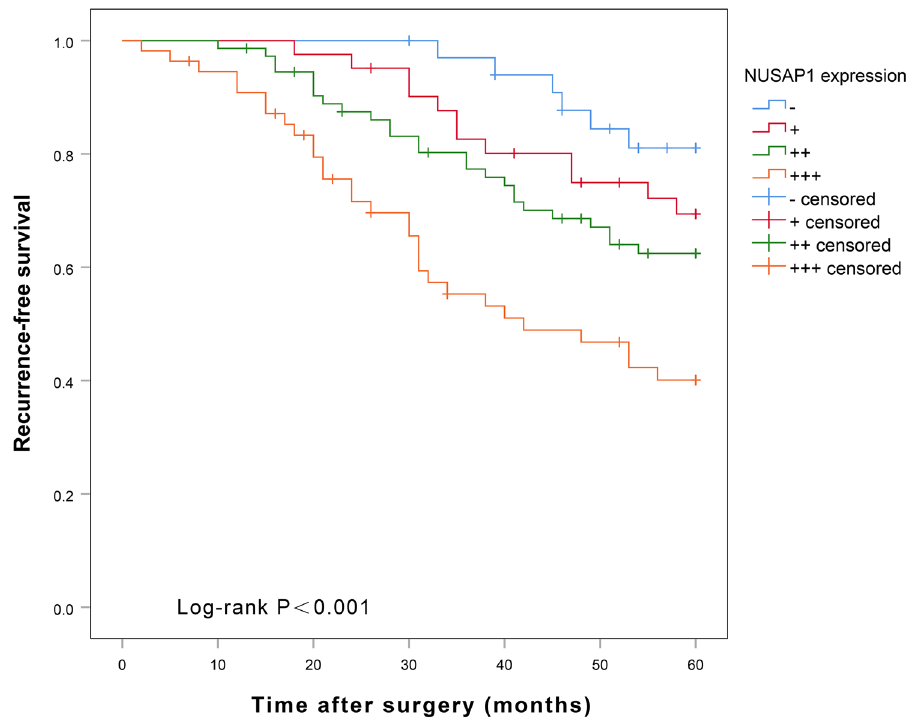
Figure 5. NUSAP1 expression levels and 5-year recurrence-free survival curves for BUC patients after radical surgery.